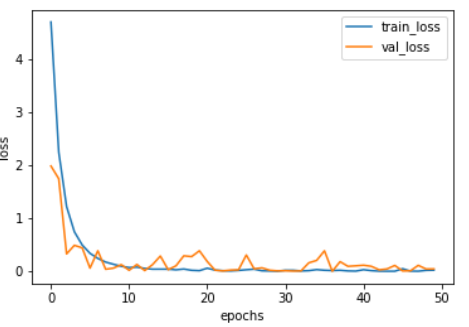
Figure 8. The loss curves of the training and validation for EV 5_2 .